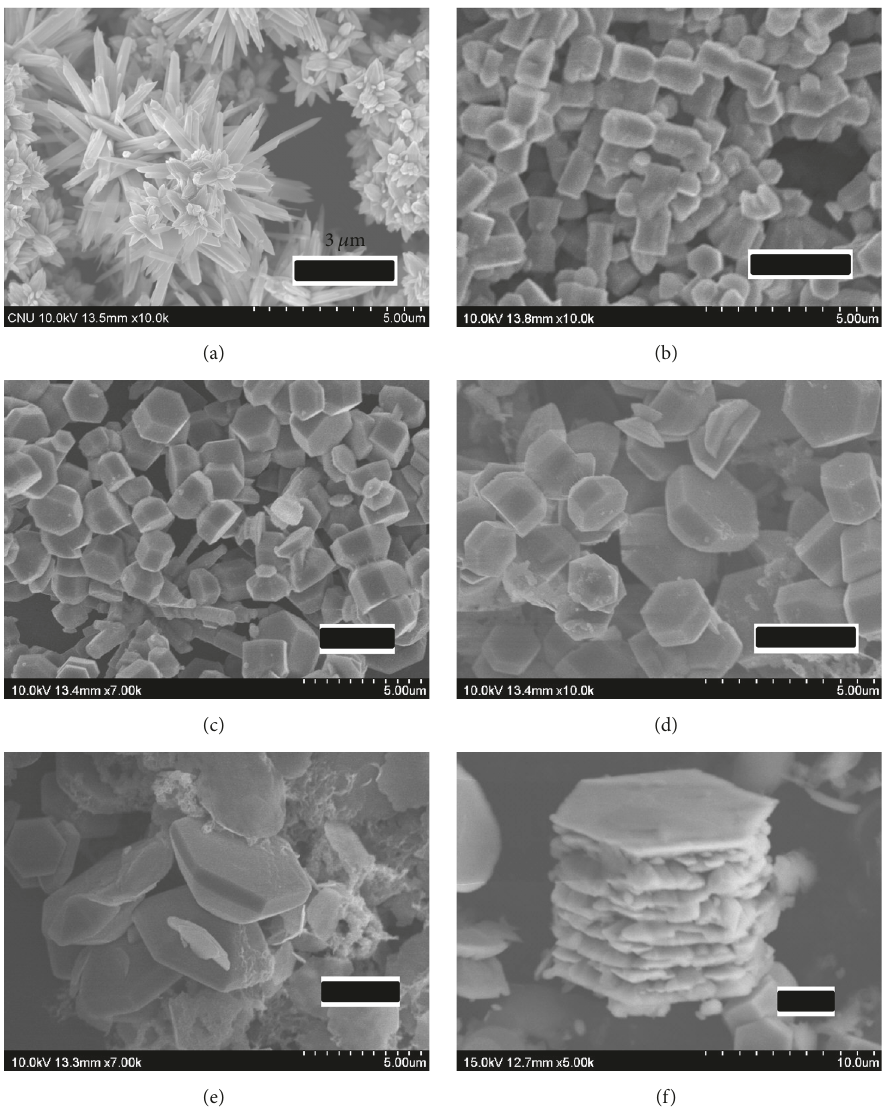
Figure 5: Typical FESEM images of ZnO nanostructures grown with different SDS surfactant concentrations of (a) 0g, (b) 0.1 g, (c) 0.2 g, (d) 0.3 g, (e) 0.4 g, and (f) 0.5